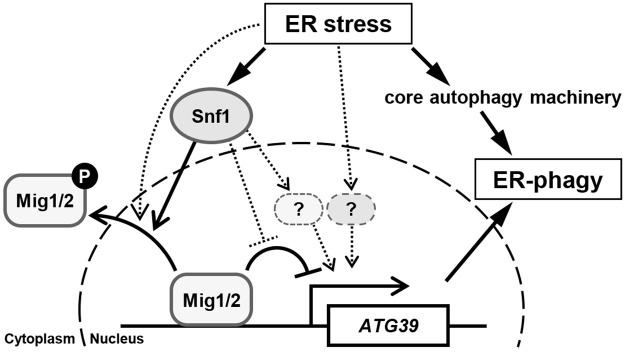
Proposed model for Snf1 and Mig1/2 in ER stress-induced ER-phagy.